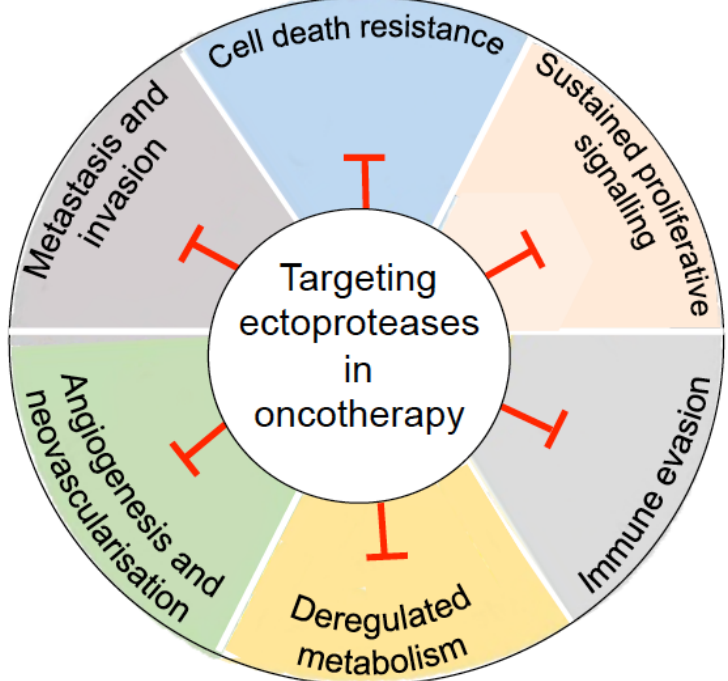
Figure 2. Cancer-associated ectoproteases as potential drug targets and implications in cancer therapy. Cancer is supported by a number of biologic hallmark capabilities that enable tumour development and progression. Ectoproteases participate in cancer by modulating a wide range of these processes. Drug candidates targeting ectoproteases may elicit antitumour effects ( T ) in a context-dependent